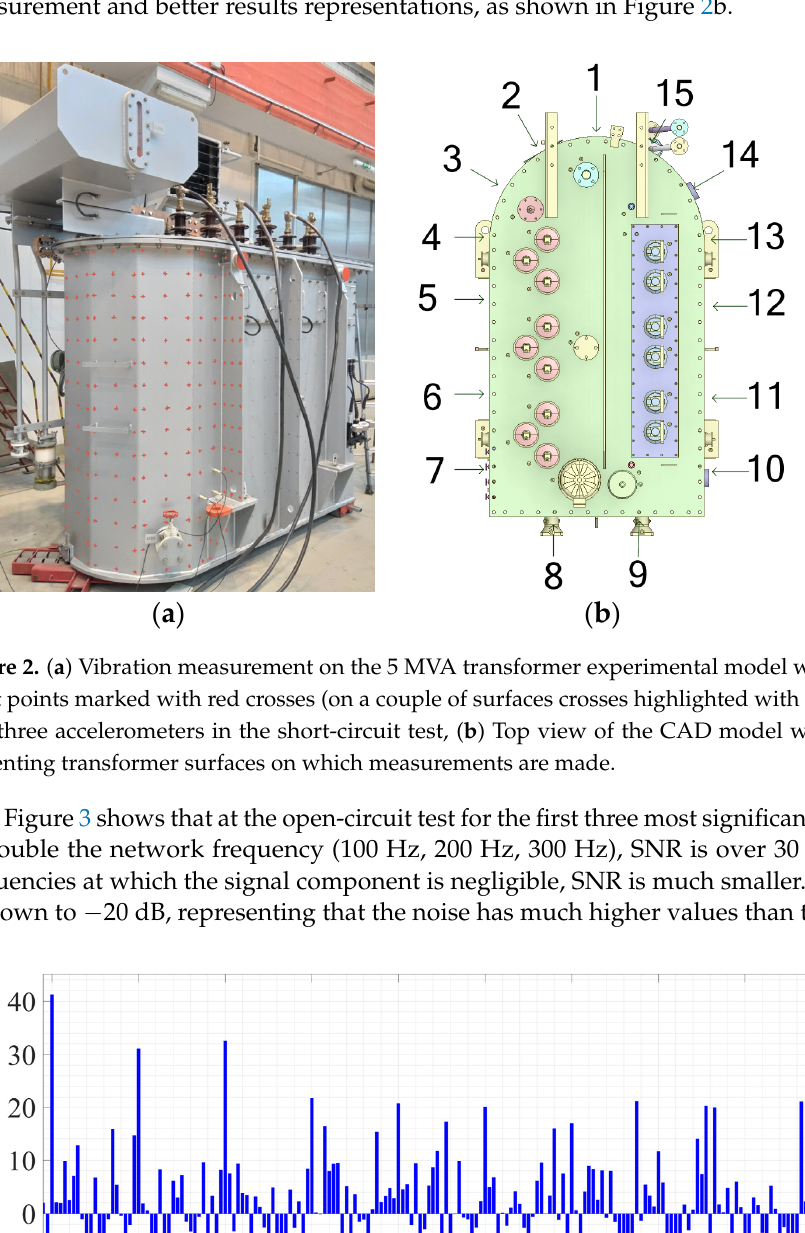
Figure 1. Electrical and vibration measurement setup diagram in open-circuit and short-circuit tests.